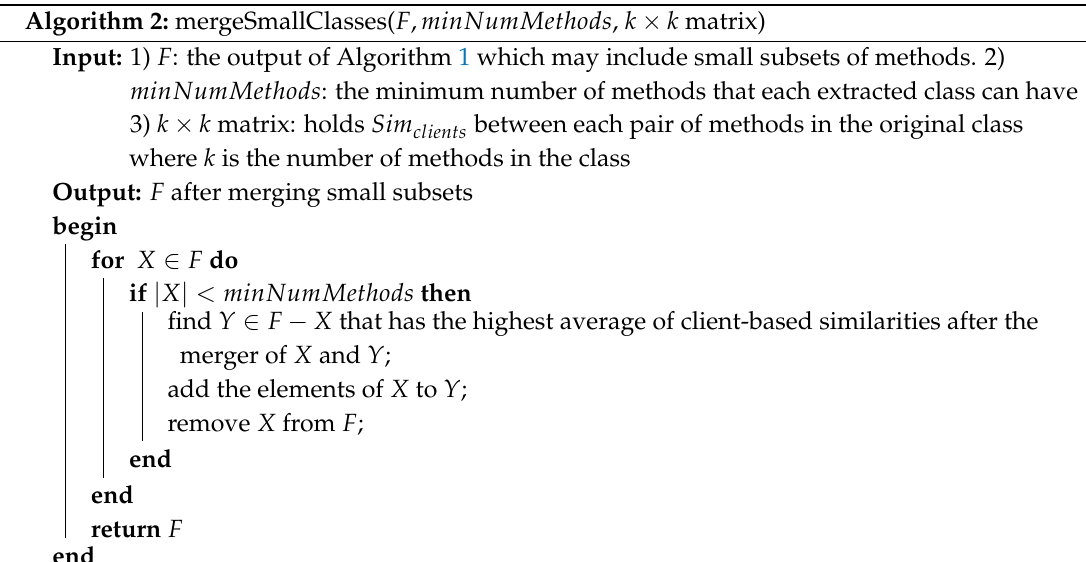
Algorithm 2: mergeSmallClasses( F , minNumMethods , k × k matrix)